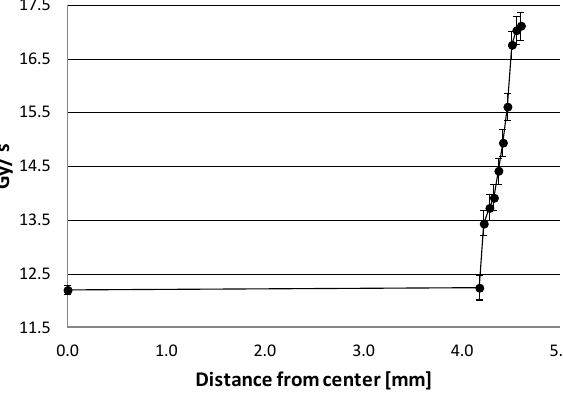
Figure 3: Simulated local α-dose rate on the surface of a pellet (the data points are connected by lines to guide the